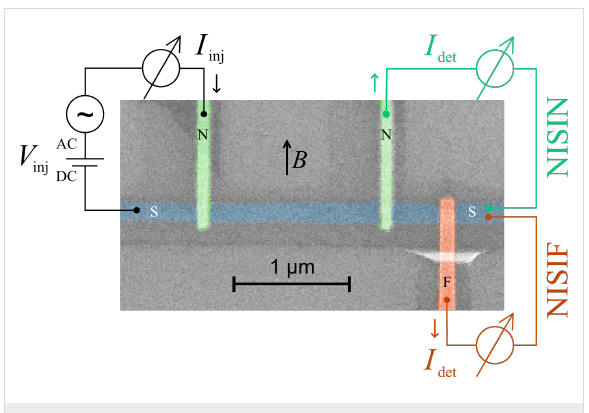
Figure 1: False color scanning electron microscopy image of one of our samples, together with the measurement scheme. The samples consist of a central superconducting wire (S), with normal-metal (N) and/or ferromagnetic (F) wires attached to it via tunnel contacts